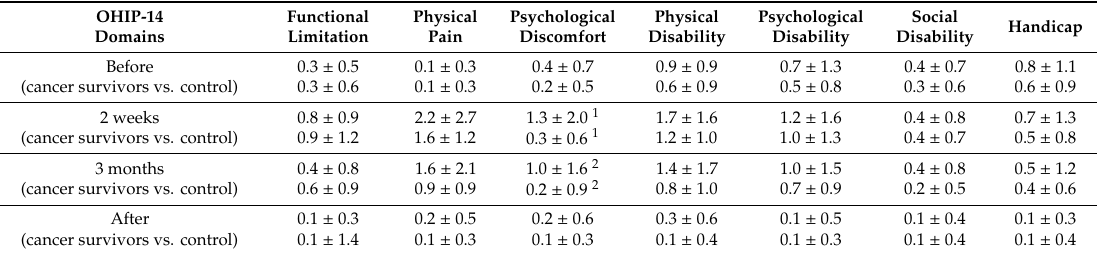
Table 5. The mean OHIP-14 score for individual domains observed before, during, and after orthodontic treatment for the cancer survivors’ and control